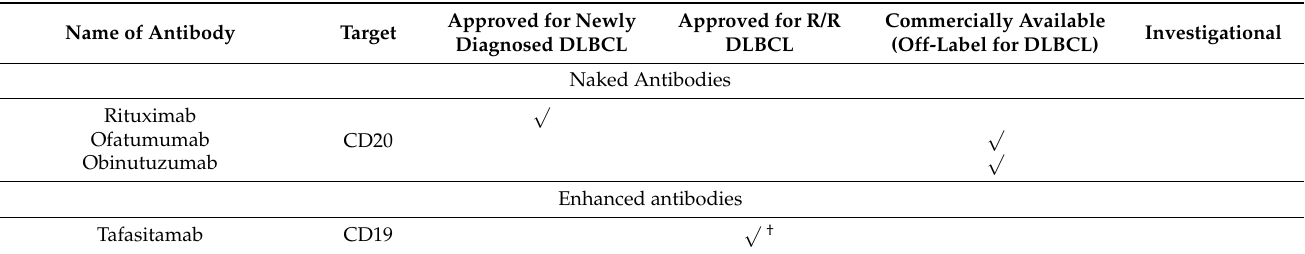
Figure 1. Overview of the monoclonal antibodies investigated for the treatment of diffuse large B-cell lymphoma. Table 1. Overview of approved and investigational monoclonal antibodies in DLBCL treatment.